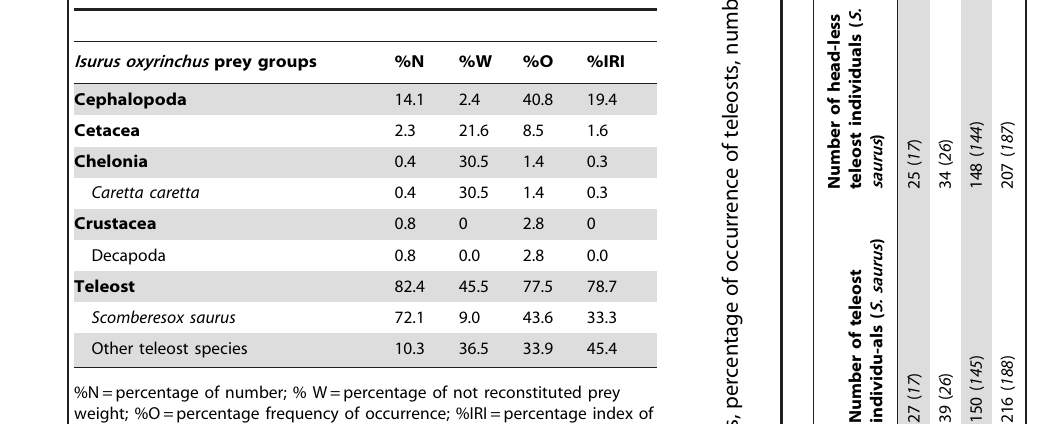
Table 2. Feeding strategies of I. oxyrinchus (n=113).